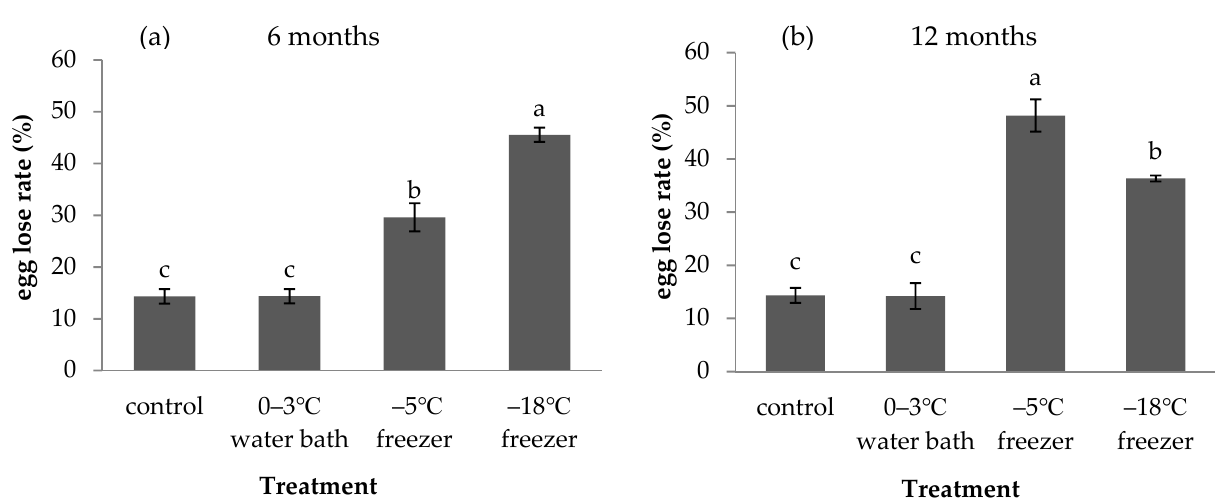
Figure 3. Rate of egg loss of A. pernyi eggs stored at low temperature for 6 months ( a ) and 12 months ( b ) (mean ± SE%). Control represents fresh eggs. Bars sharing the same letters are not significantly different (one-way ANOVA, followed by LSD multiple comparison tests, p < 0.05) between different treatments.